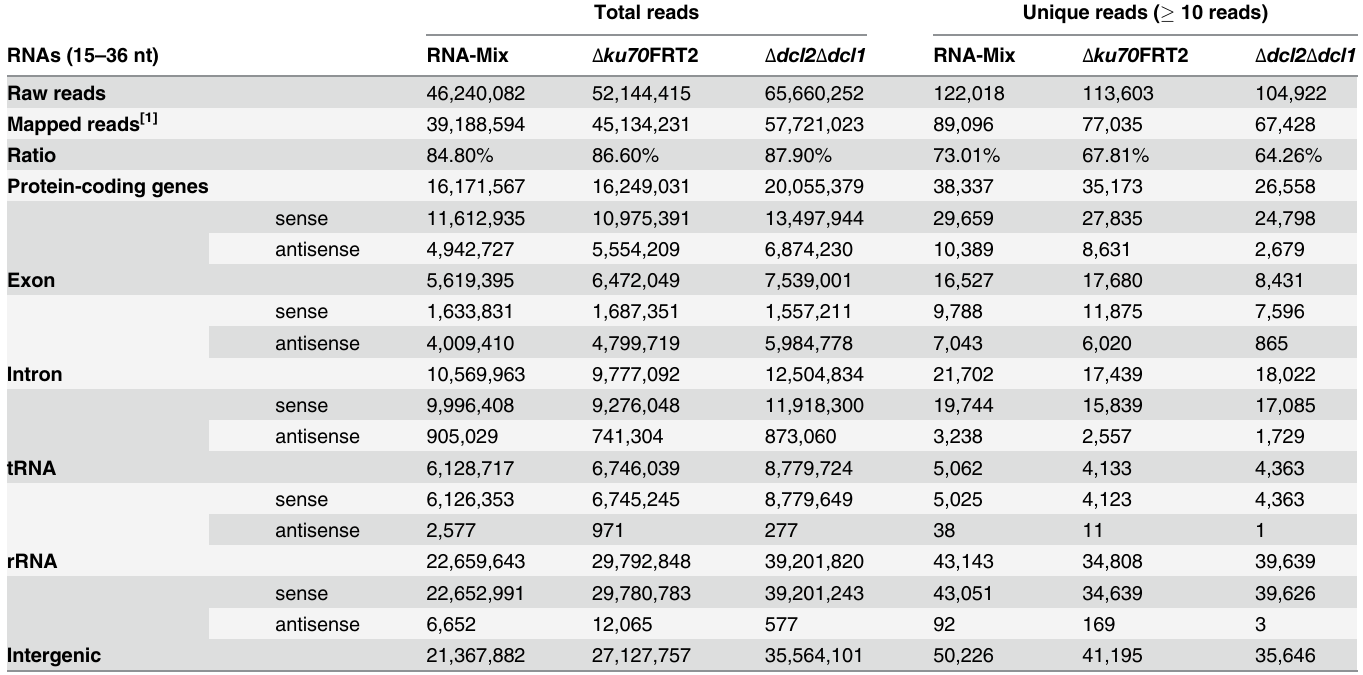
Table 1. Statistical summary of small RNA sequencing data and distribution of small RNAs with perfect match to the genome sequence of P . chrysogenum